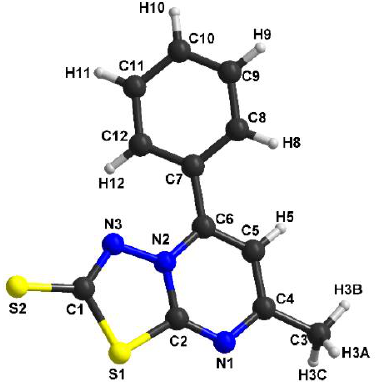
Figure 4. The molecular structure with atom numbering for ( 2 ).